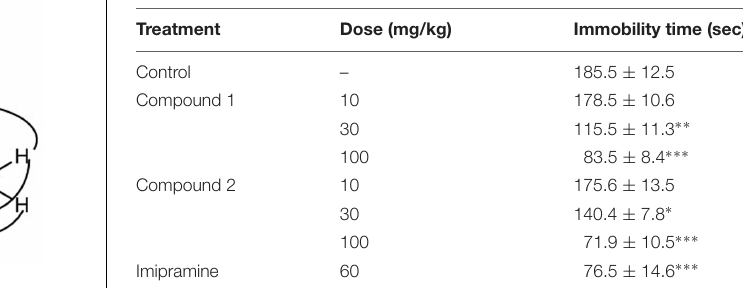
TABLE 3 | Effect of compounds on immobility time (sec) of mice using forced swimming